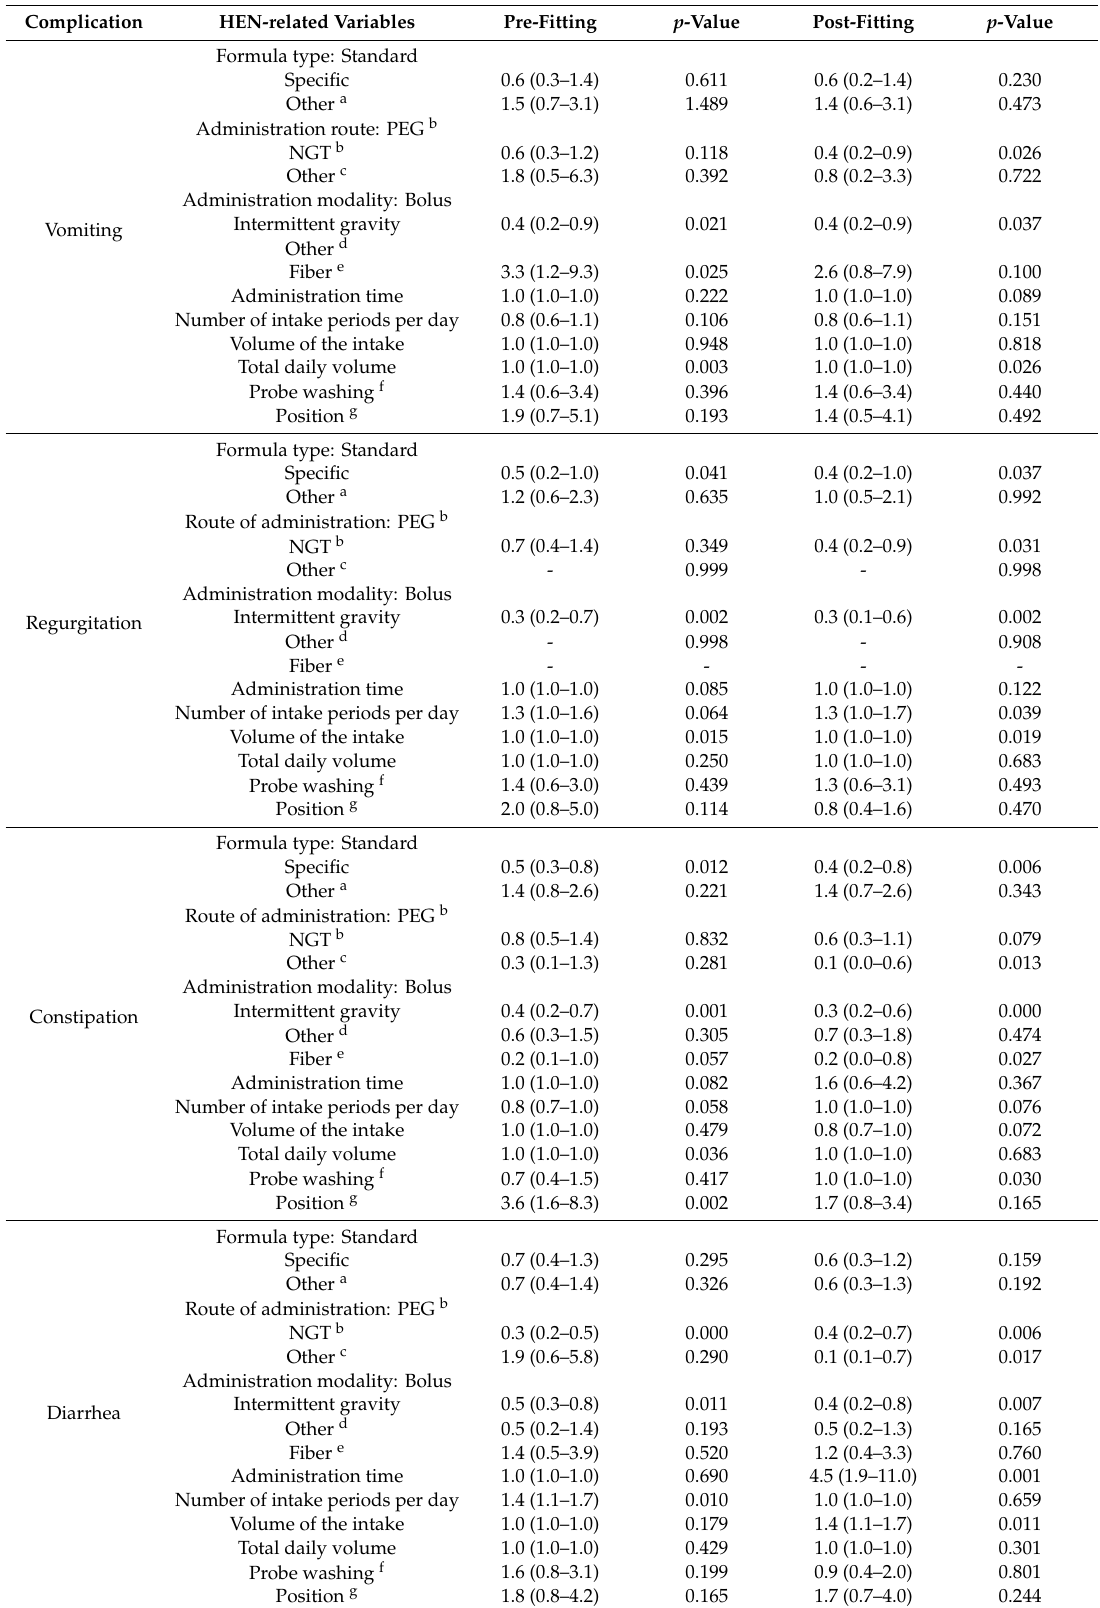
Table 4. Complications related to the type and modality of HEN